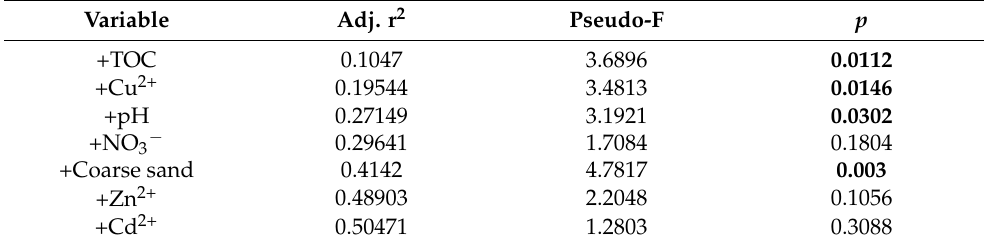
Table 5. Variables selected by distLM as the most affecting biological data showed in their cumulative contribution to total variation Adj, r 2 , and the significance ( p in bold) of their own pseudo-F value.